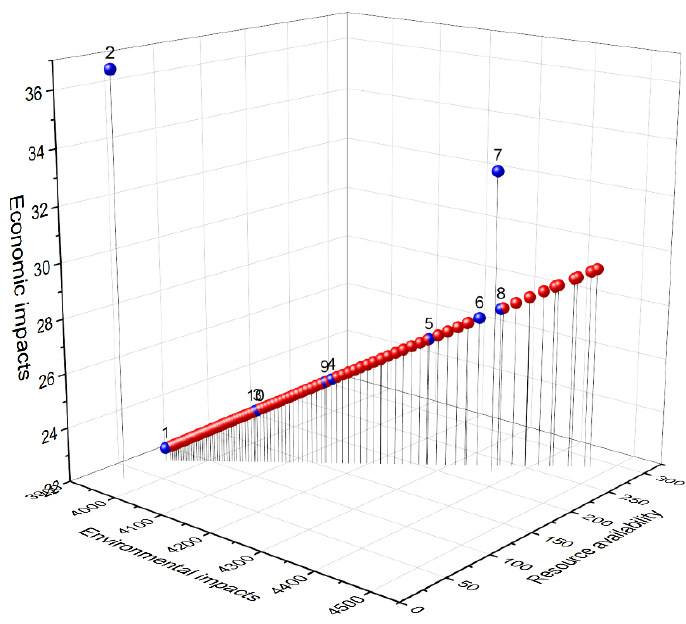
Figure 3. Optimal mixes with alternative materials in Belgium.